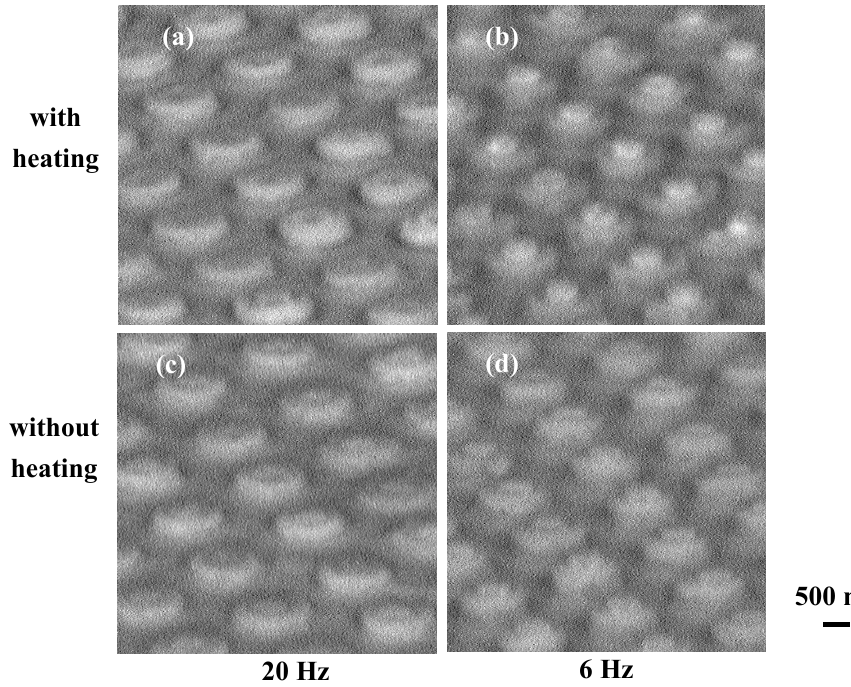
Figure 4. SEM images of the photochemical micro-/nano-swelling formed on silicone rubber with (a,b) and without heating (c,d) at 80 °C. The pulse-repetition rate was 20 and 6 Hz.